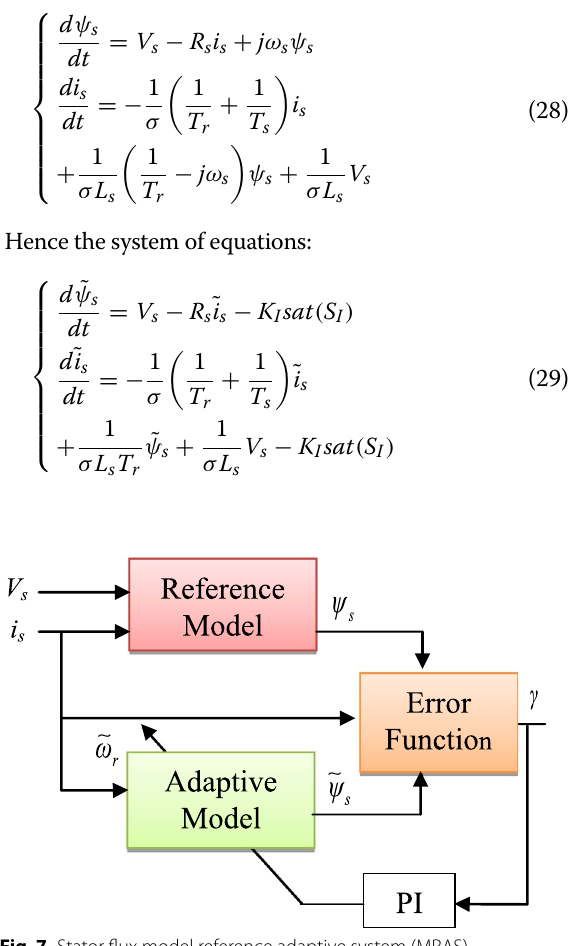
Fig. 7 Stator flux model reference adaptive system (MRAS) Fig. 8 Stator flux sliding mode observer